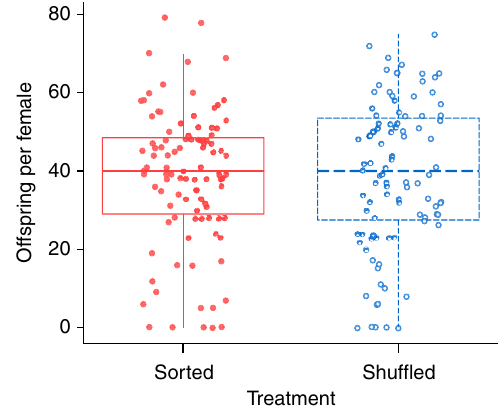
Figure 4 | Comparison of post-invasion reproductive rates. Tukey boxplots showing the number of offspring per female in spatially sorted (red solid boxes, closed circles) and shuffled (blue dashed boxes, open circles) replicates, following one generation in a common environment (nine replicate populations per treatment, 11 females per replicate, N ¼ 198). Results from a second generation in a common environment were similar (Supplementary Fig. 7). Model selection using generalized linear mixed models (GLMMs) suggests no difference between treatments (model selection results in Supplementary Table 7). Points show raw data, and are jittered along the x axis to reduce